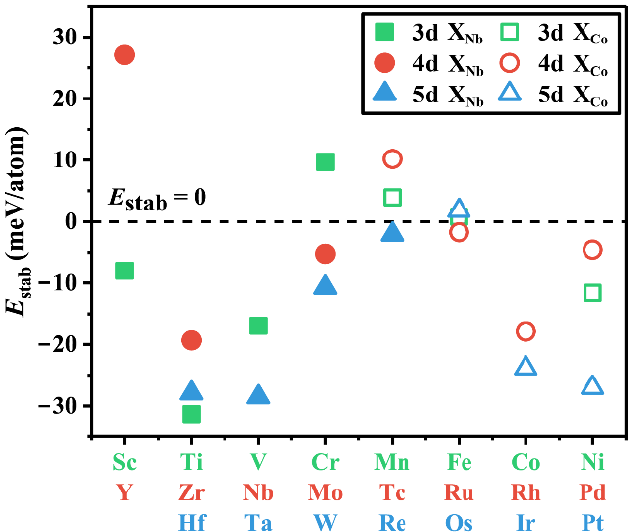
Figure 4. Calculated stable formation energy for γ′ -Co 3 Nb doped with 3d, 4d and 5d transition metal elements X.